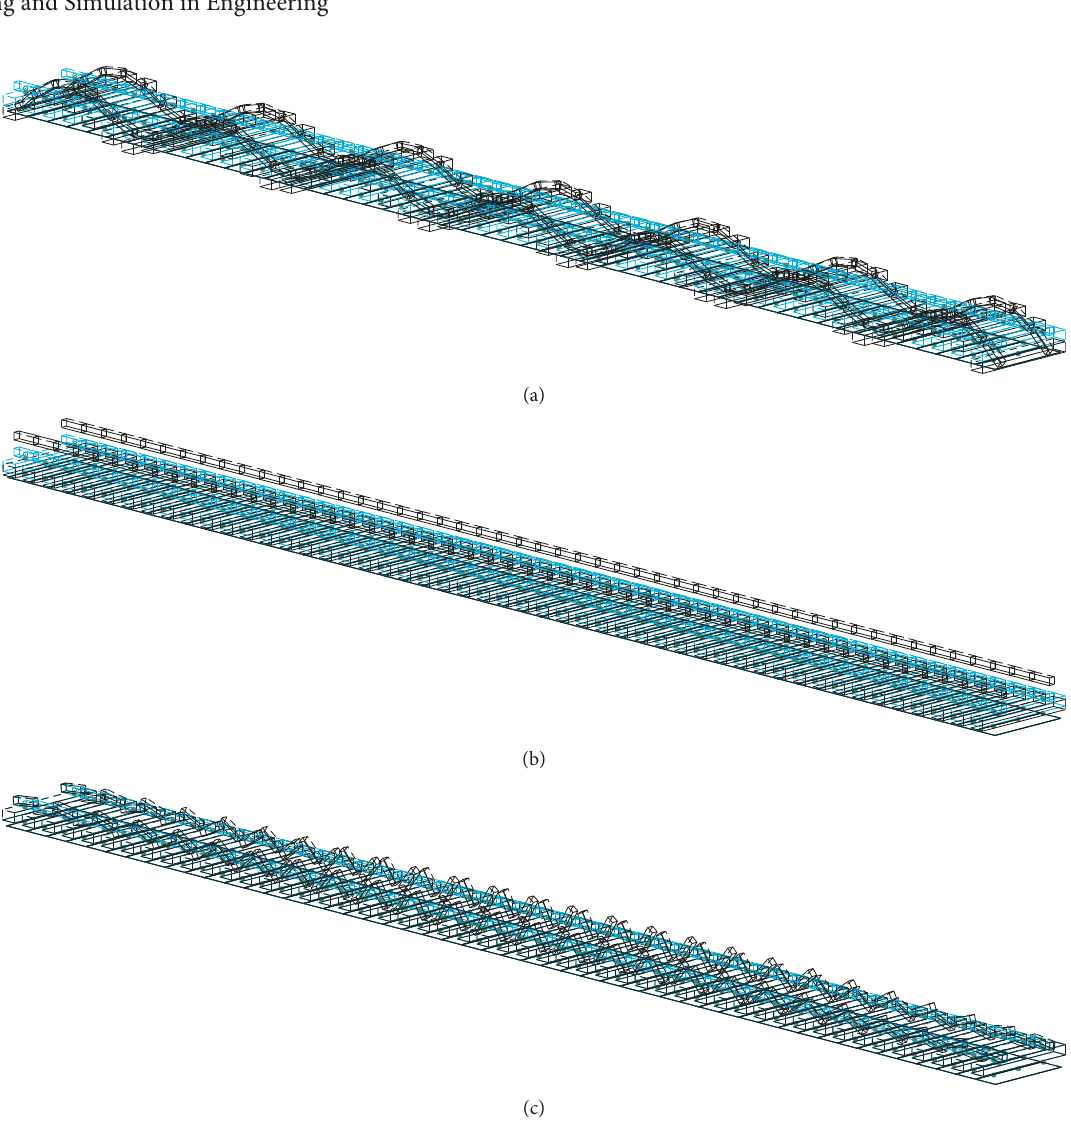
Figure 3: Mode shapes: (a) 129.10Hz, (b) 505.08Hz, and (c)